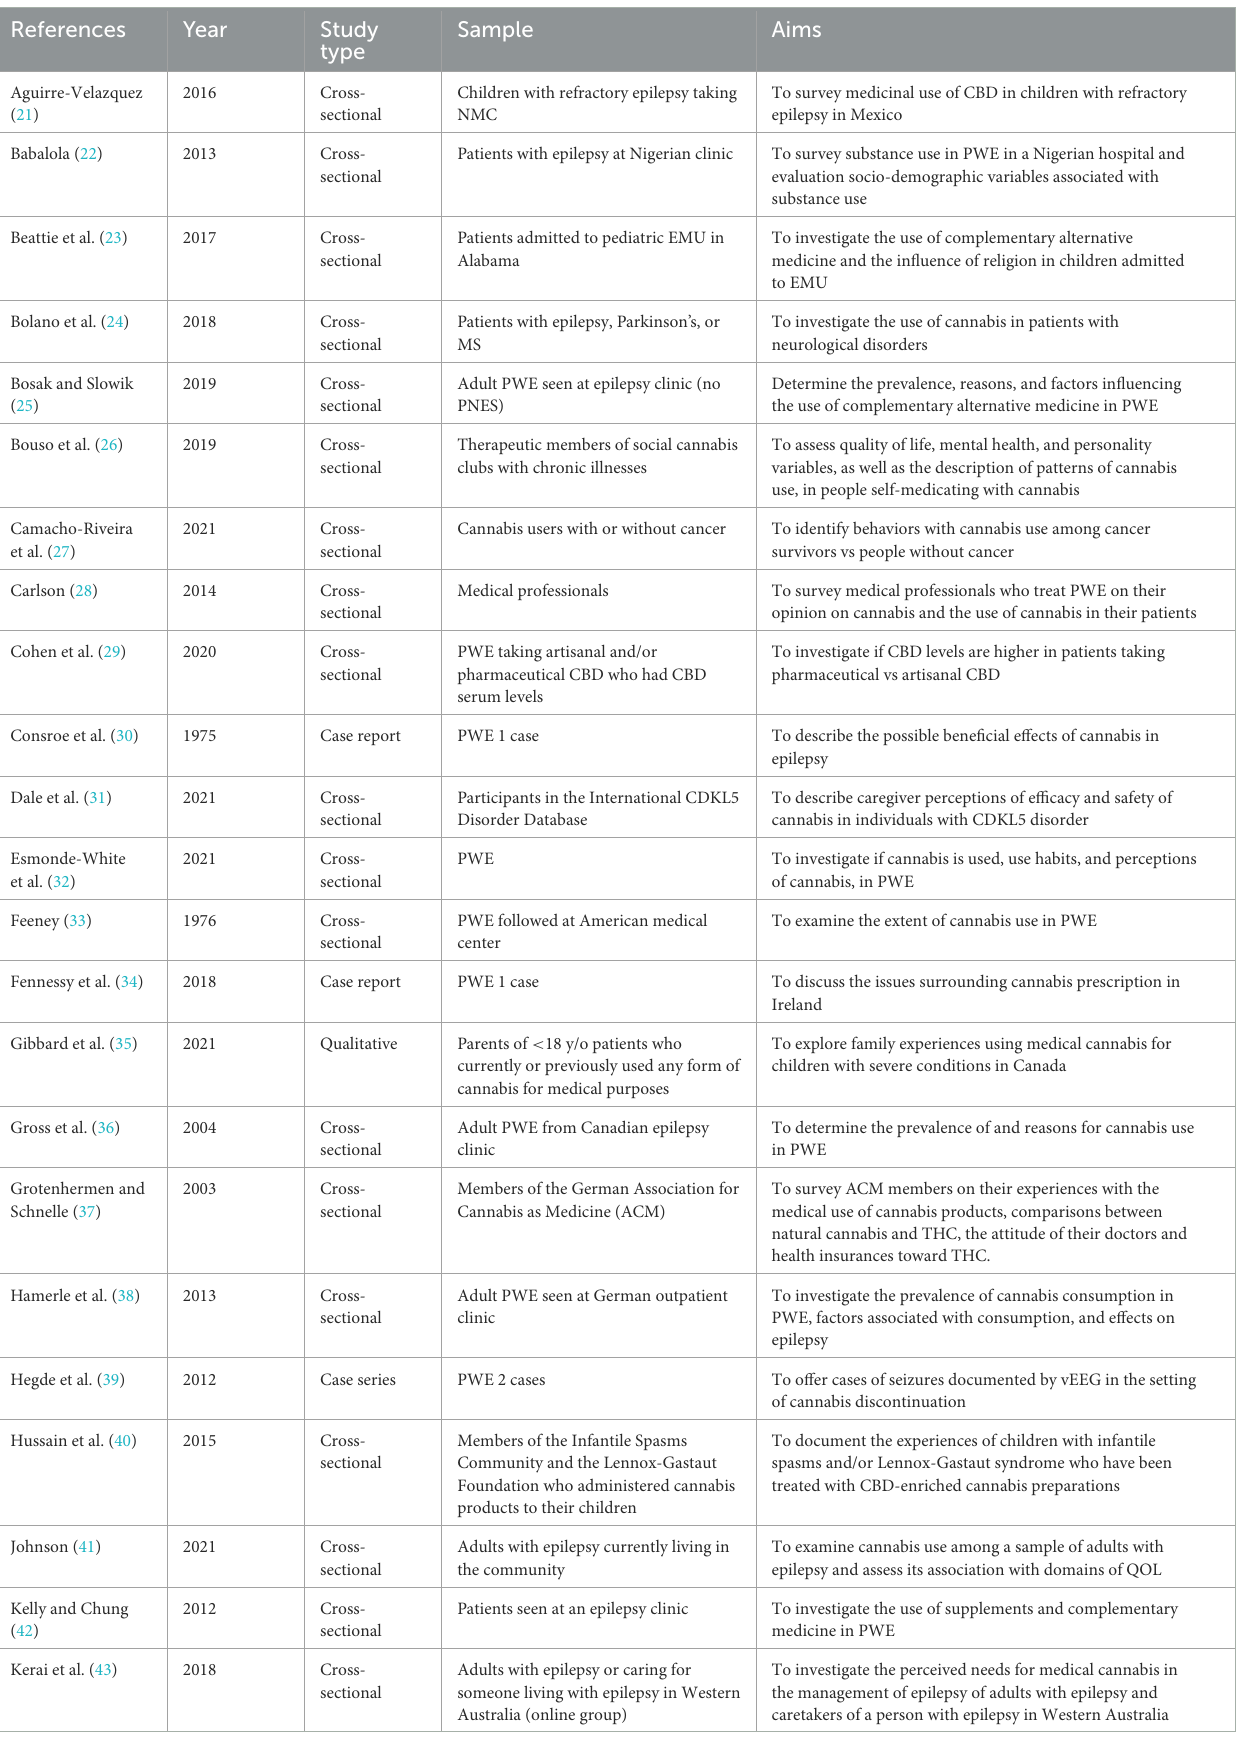
TABLE 1 Summary of the study types, samples, and aims of included